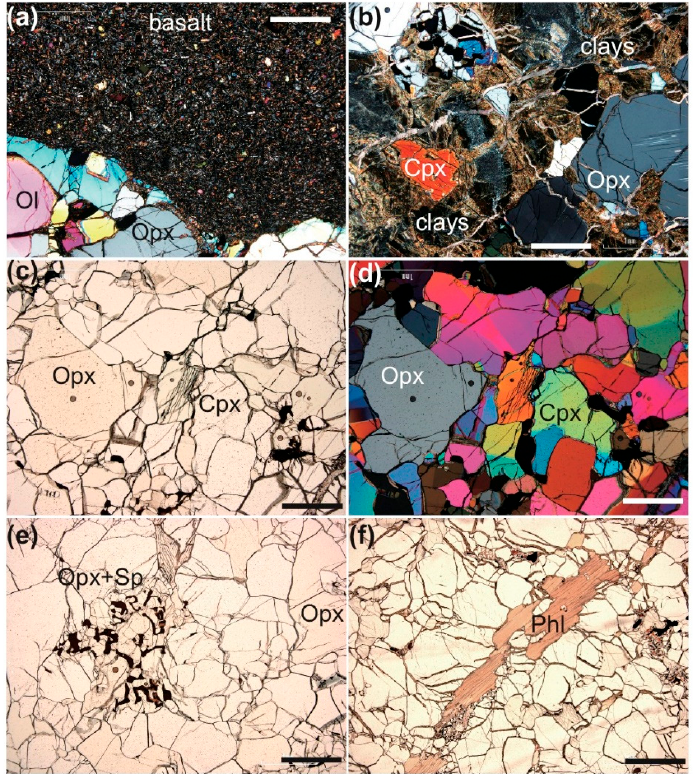
Figure 3. Photomicrographs. ( a , b , d ) by crossed-polarized light. ( c , e , f ) by plane-polarized light. Scale bar is 1 mm. Abbreviations; Ol, olivine: Opx, orthopyroxene: Cpx, clinopyroxene: Sp, chromian spinel: Phl, phlogopite. ( a ) Lherzolite xenolith (lower) in sparsely phyric alkali basalt. Note a thin reaction zone between orthopyroxene and the host basalt. No. IZS-1; ( b ) altered lherzolite (IZS-6). Olivine has been completely altered to clays. Note thin clinopyroxene lamellae in the core of orthopyroxene; ( c , d ) Prortogranular texture of lherzolite (IZS-1); ( e ) vermicular aggregate of chromian spinel and orthopyroxene in lherzolite (IZS-3); ( f ) phlogopite veinlet mainly replacing olivine in lherzolite (IZS-12).